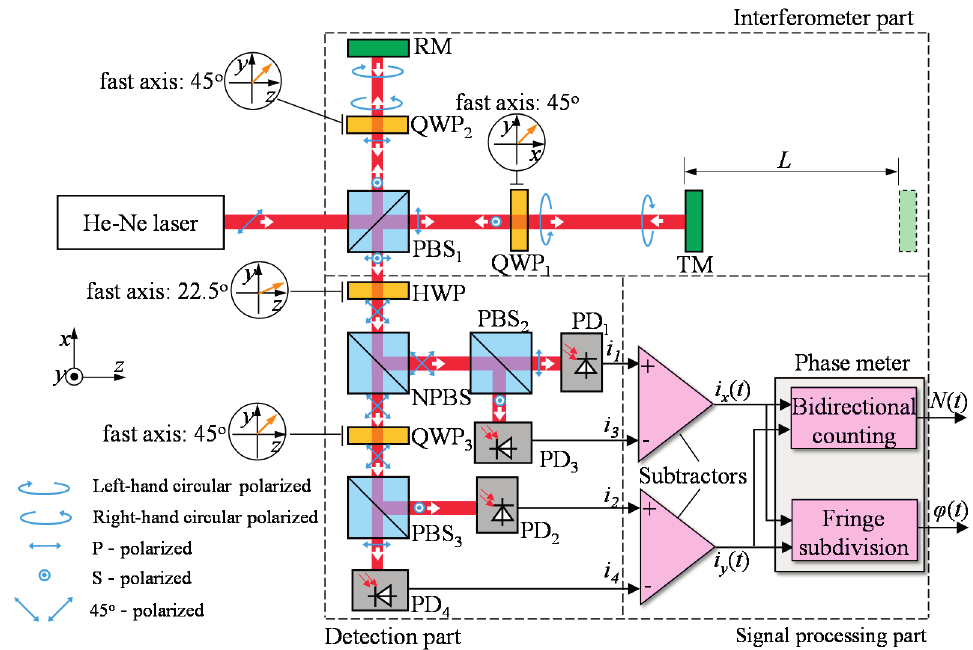
Figure 1. Schematic diagram of the homodyne interferometer with quadrature detection system. Polarizing Beam Splitter (PBS), Quarter-Wave Plate (QWP), Target Mirror (TM), Reference Mirror (RM), Half-Wave Plate (HWP), Non-Polarizing Beam Splitter (NPBS), Photo Detector